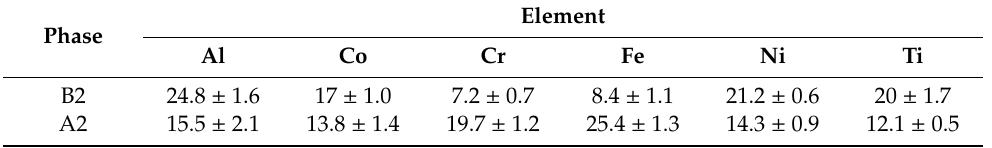
Table 2. Elemental composition (atom %) of each phase in the HEA by SEM-EDS (more than 5 locations). Element Phase Figure 3. ( a ) Secondary electron images of the interface between the AlCoCrFeNiTi 0.5 HEA coating and Ti6Al4V substrate, ( b ) energy dispersive spectroscopy (EDS) line scan along the white arrow line in ( a ), ( c ) and ( d ) backscattered electron images of the HEA microstructure at different magnifications.